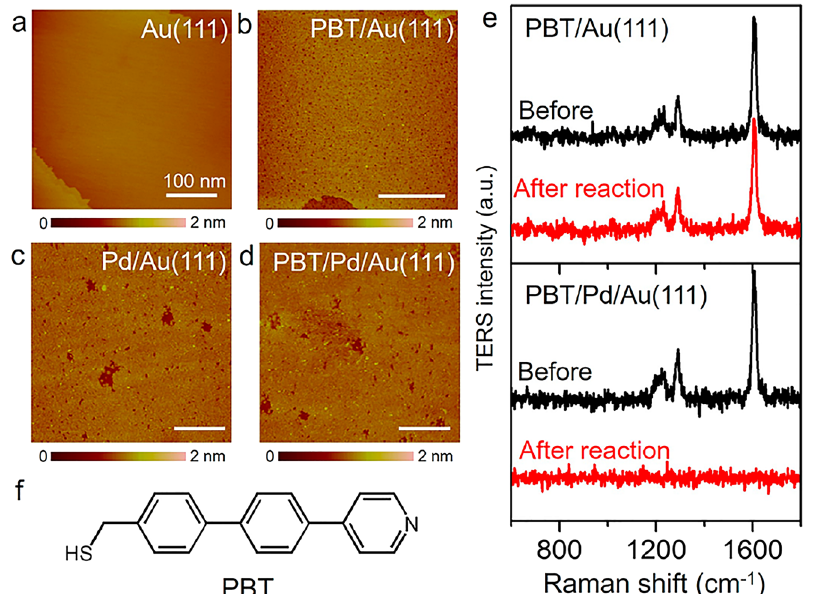
Figure 14: STM images of (a) Au (111) surface, (b) PBT/Au (111) surface, (c) Pd/Au (111) surface and (d) PBT/Pd/Au (111)